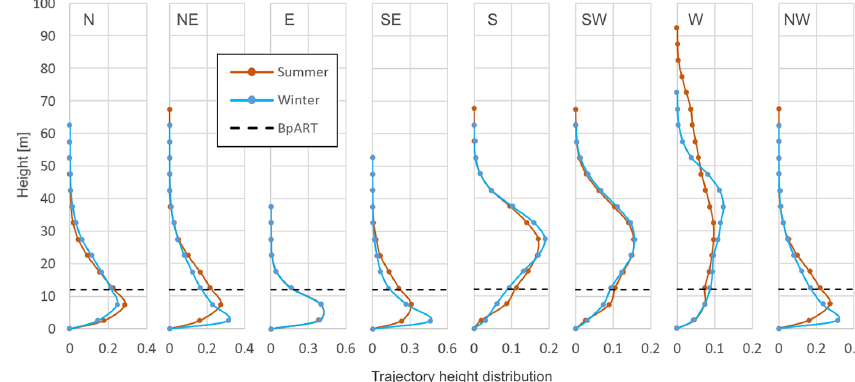
Figure 6. Histogram of the starting point height at a distance of 600m from the BpART facility for the eight major wind sectors (N, NE, E, SE, S, SW, W and NW) for summer (vegetation with leaves) and winter (no vegetation). The sampling height of the platform is indicated by dashed